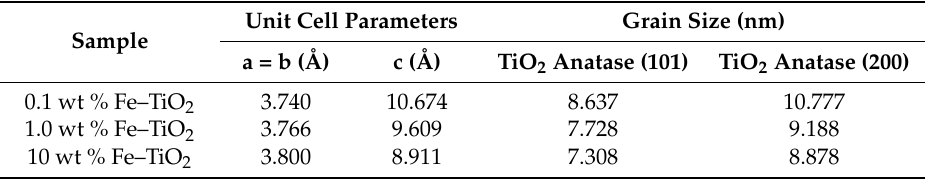
Table 3. Unit cell parameters and grain sizes of TiO 2 in TCF with different doping amounts of Fe 3+ .